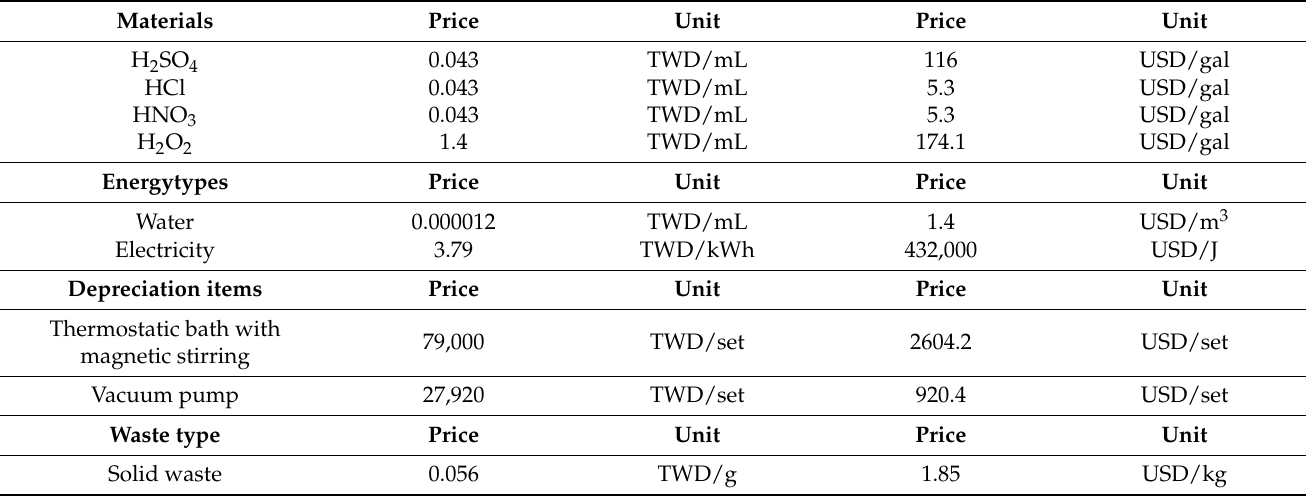
Table 2. The expenditure of materials, energy types, depreciation items, and waste type in the leaching process at lab